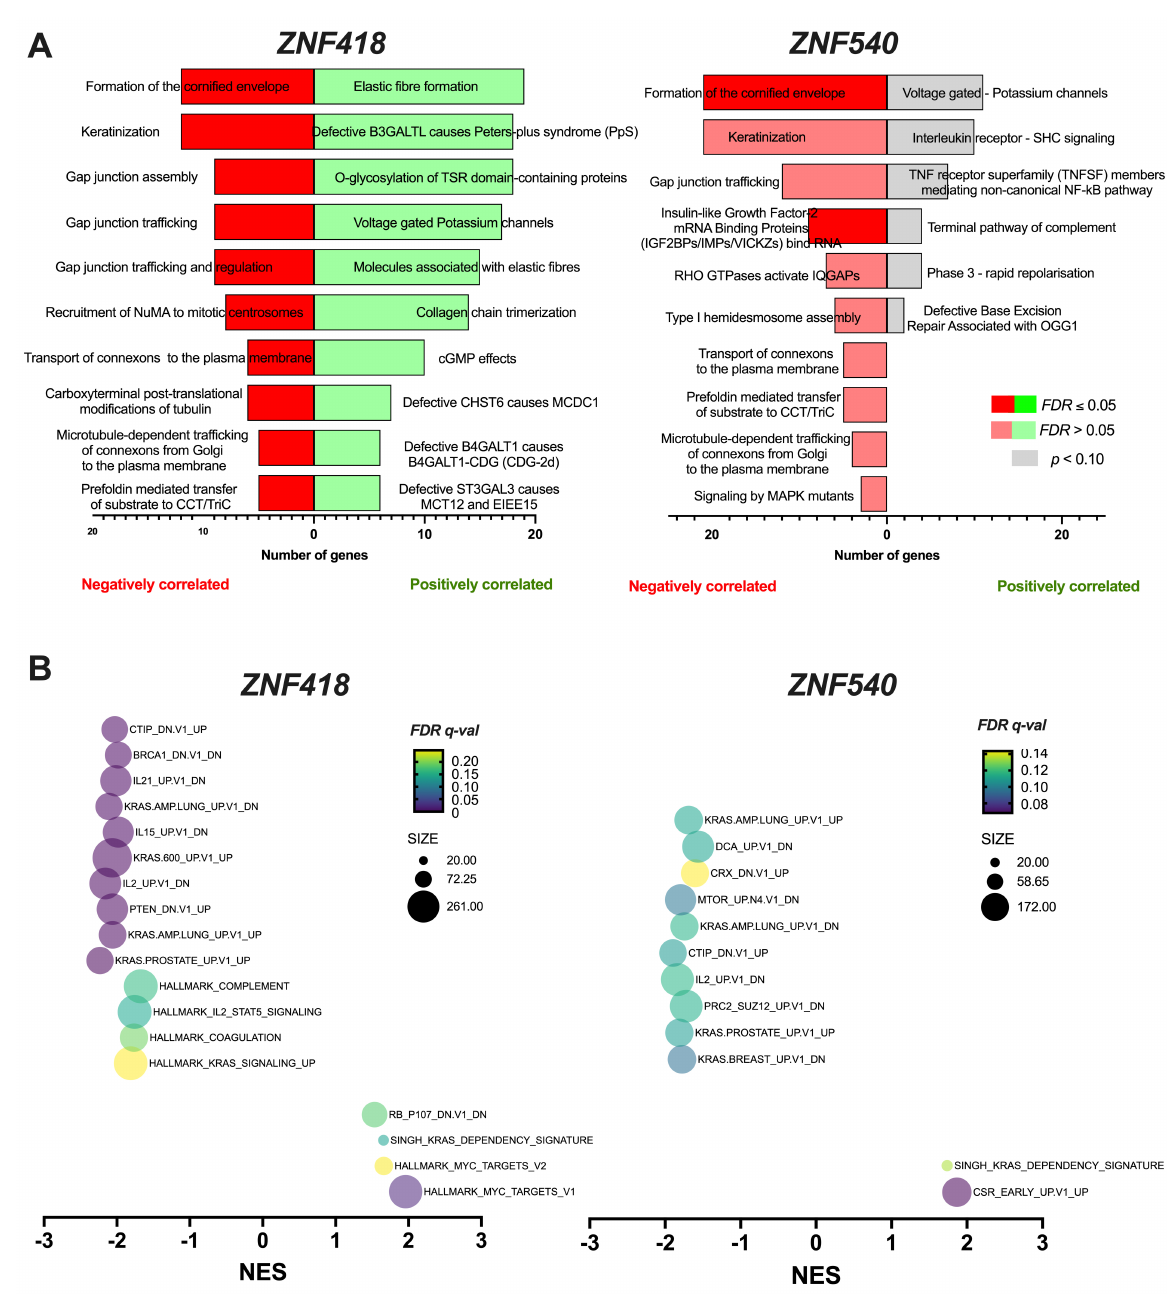
Figure 4. Association of ZNF418 and ZNF540 genes in cell processes and pathways in patients with HNSCC: ( A ) Classification of genes negatively and positively correlated with cellular processes and pathways based on the analysis of the REACTOME database. Only genes with Spearman’s correlation ( R < − 0.3 and R > 0.3, p < 0.05) were included in the analysis, and negatively correlated processes and pathways are marked in red, and positively in green. Results were marked in dark colors for FDR ≤ 0.05 and in light colors for FDR > 0.05; p < 0.05 was considered statistically significant and only for p < 0.10, it was indicated in gray. ( B ) GSEA of patients analyzed in groups of low vs. high expression of ZNF418 ( n Low = 271, n High = 250) and ZNF540 ( n Low = 261, n High = 260). Normalized enrichment scores for GSEA of MSigDB gene sets for the Hallmark gene set and oncogenic signatures. Only results with p ≤ 0.05 and FDR ≤ 0.25 were shown. NES (normalized enrichment score), p -Val (nominal p -value), and FDR q -val (false discovery rate); n —number of